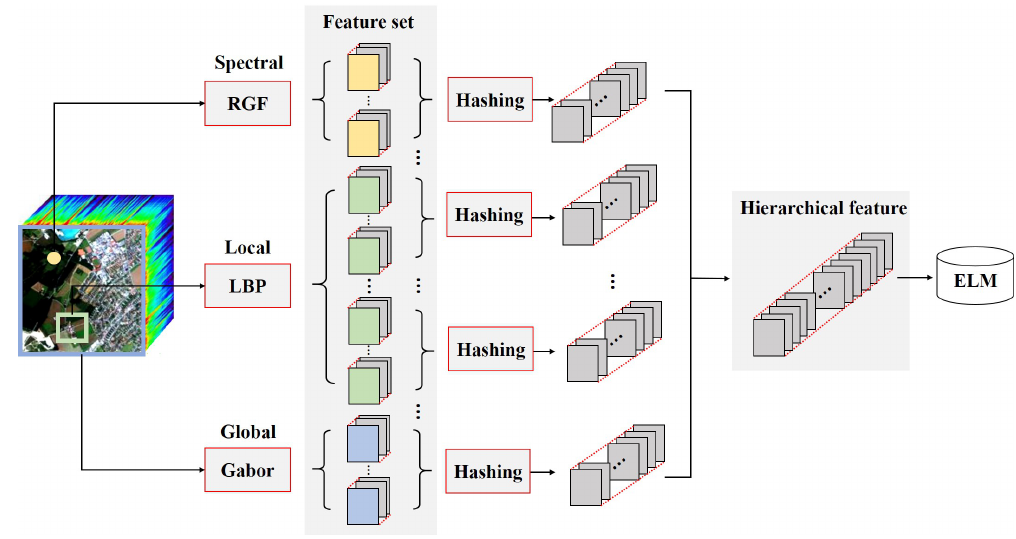
Figure 1. The flowchart of the H 2 F based